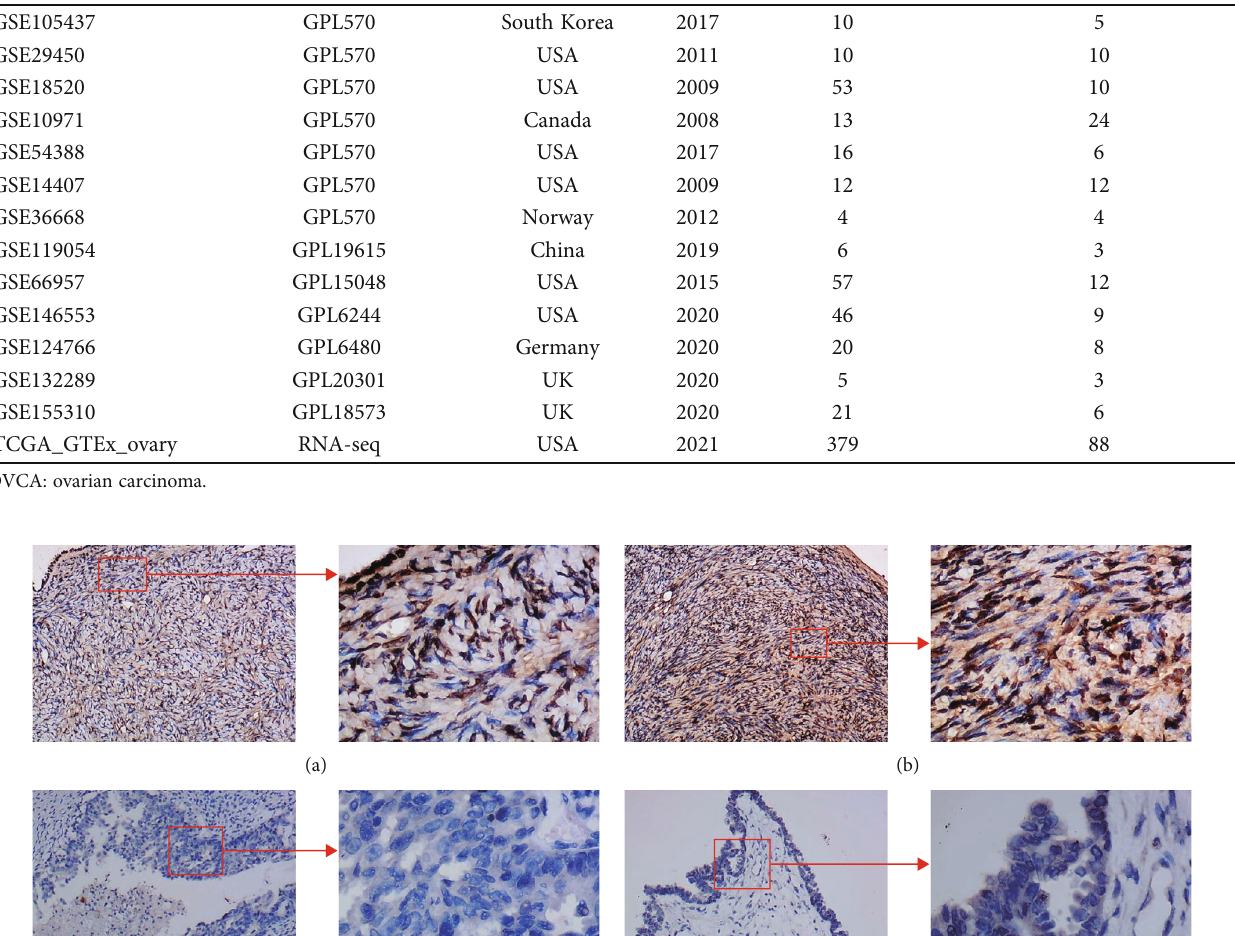
Table 1: General characteristics of microarray and RNA-sequencing datasets on ovarian carcinoma. Study